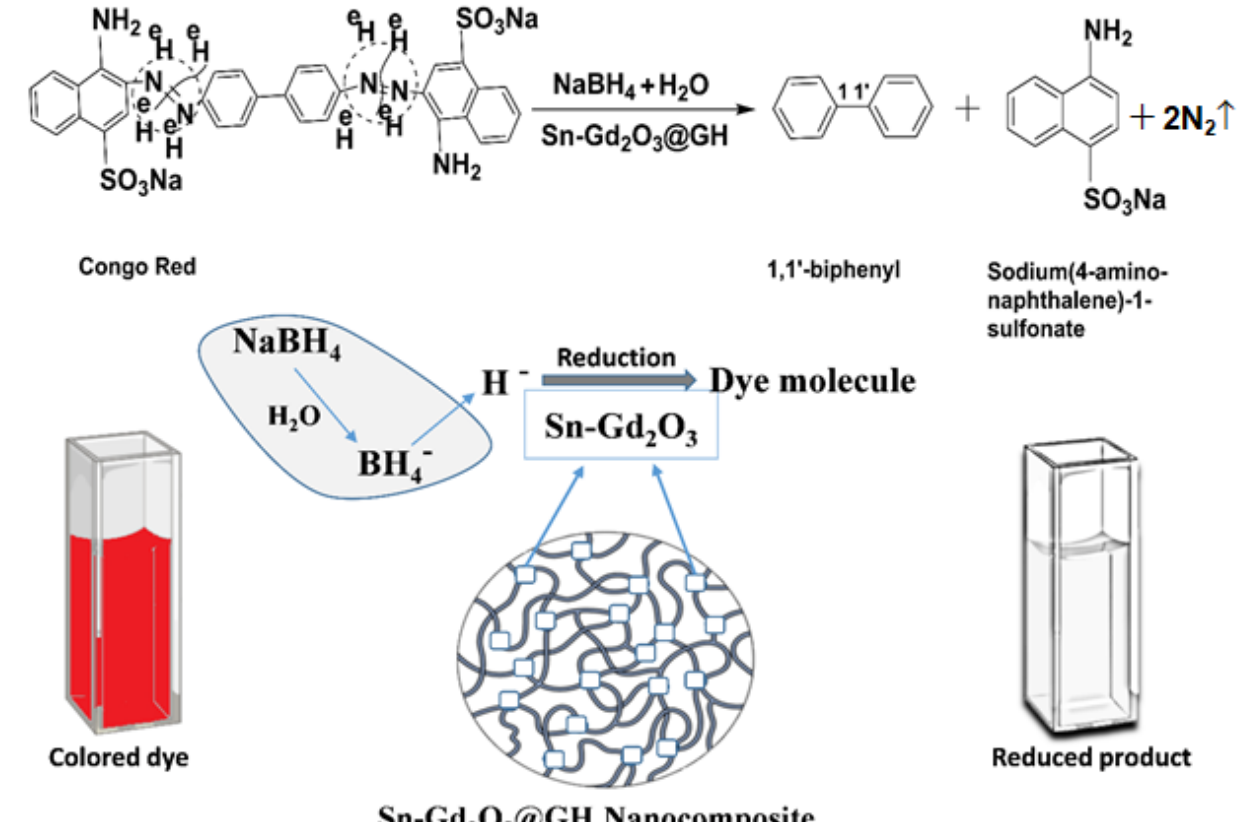
Figure 9. Scheme for the reduction of the CR by NaBH4 using Sn-Gd2O3@GH hydrogel catalyst.